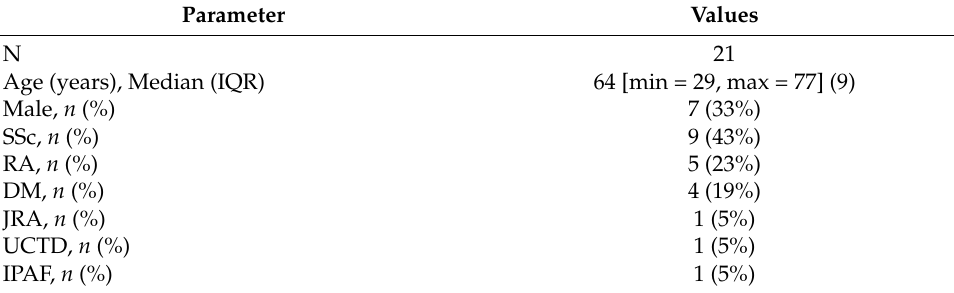
Table 1. Patients’